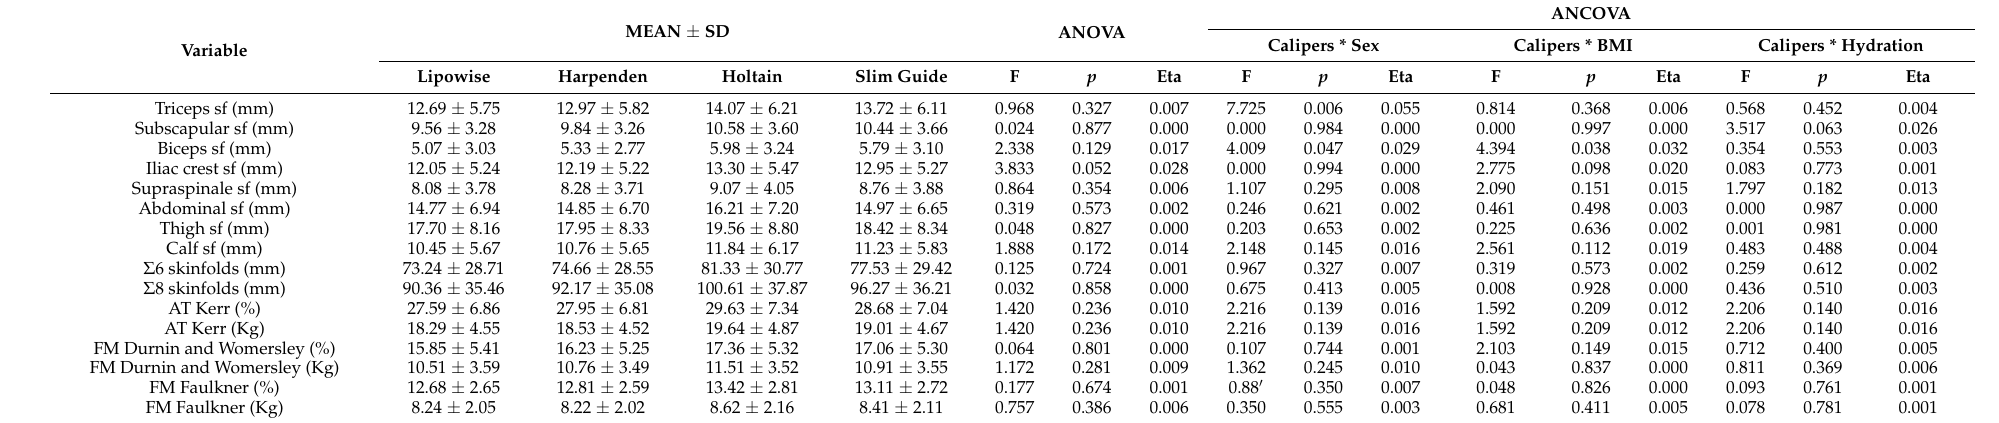
Table 3. Descriptive statistics and differences between the variables calculated with different